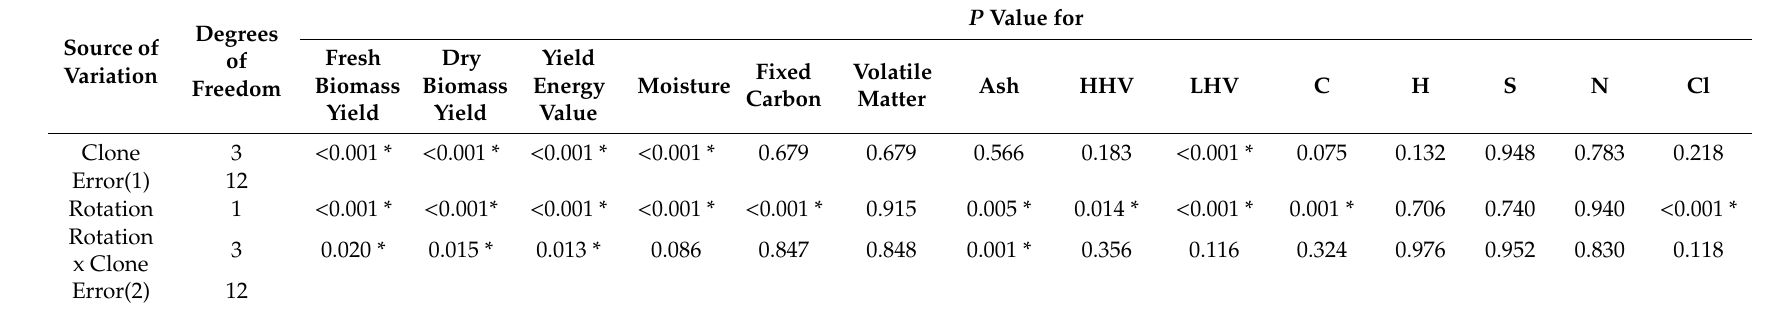
Table 1. Analysis of variance repeated measure for the analysed features *.